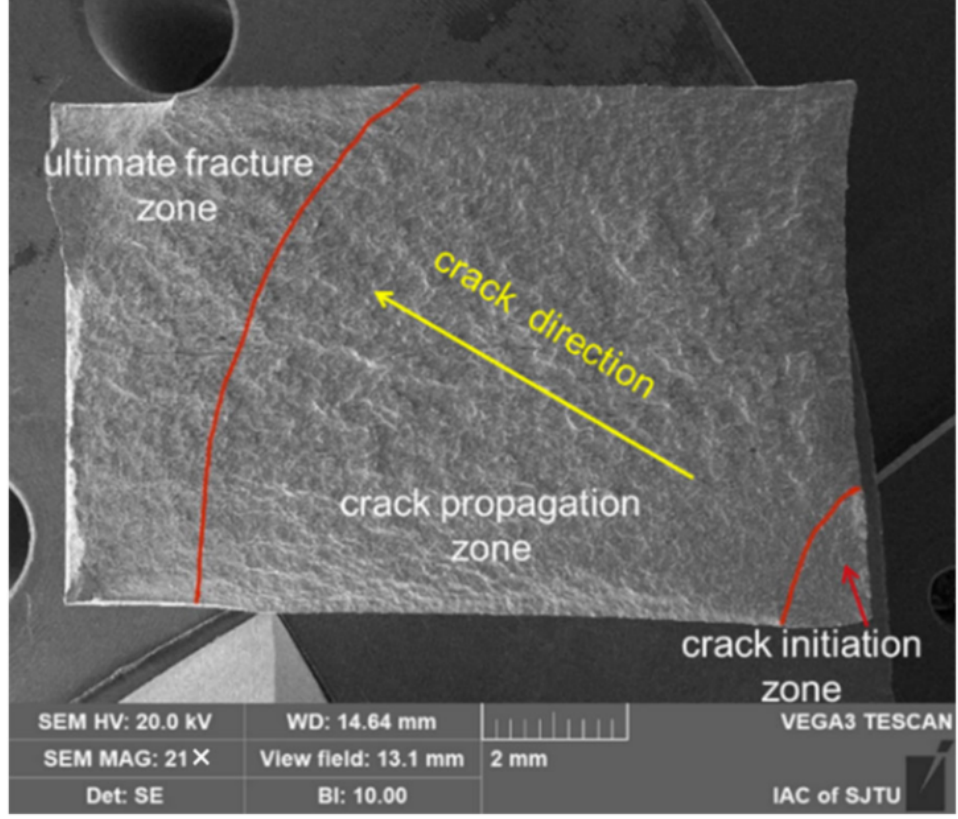
Figure 10. The appearance of fracture for